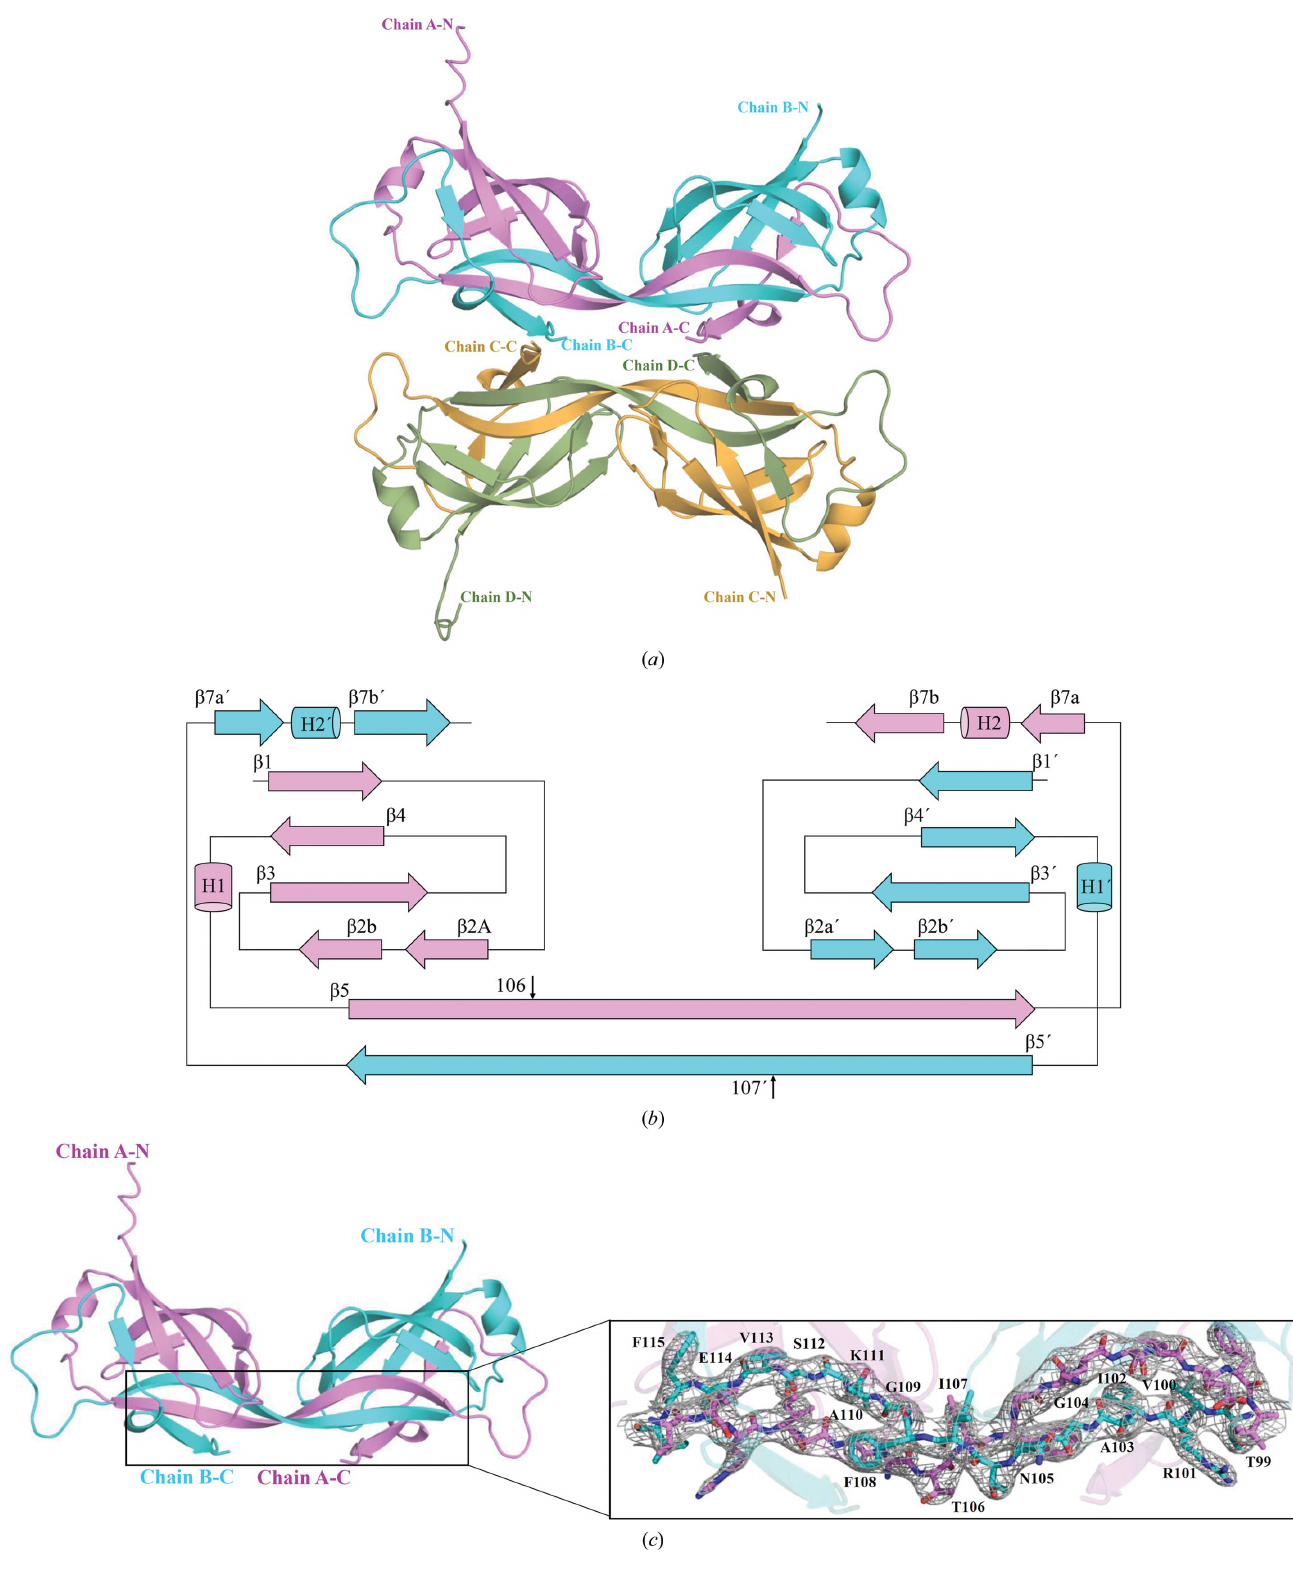
Figure 3 ( a ) Crystal structure of MtMce4A 39–140 with four molecules in the asymmetric unit. ( b ) Topology of the MtMce4A 39–140 domain-swapped dimer. (cid:2) -Strands are shown as arrows and helices as cylinders. The secondary structures of chain A and chain B are shown in pink and cyan, respectively. The secondary-structure elements and residue numbers for chain B are indicated with primes. The residues after the black vertical arrow are involved in domain swapping. ( c ) The domain-swapped dimer residues of (cid:2) 5 and (cid:2) 5’ are highlighted and shown in the inset. The 2 F o (cid:4) F c electron-density map contoured at 1.5 (cid:6) is shown as a gray mesh. These residues are important for the arrangement of the domain-swapped